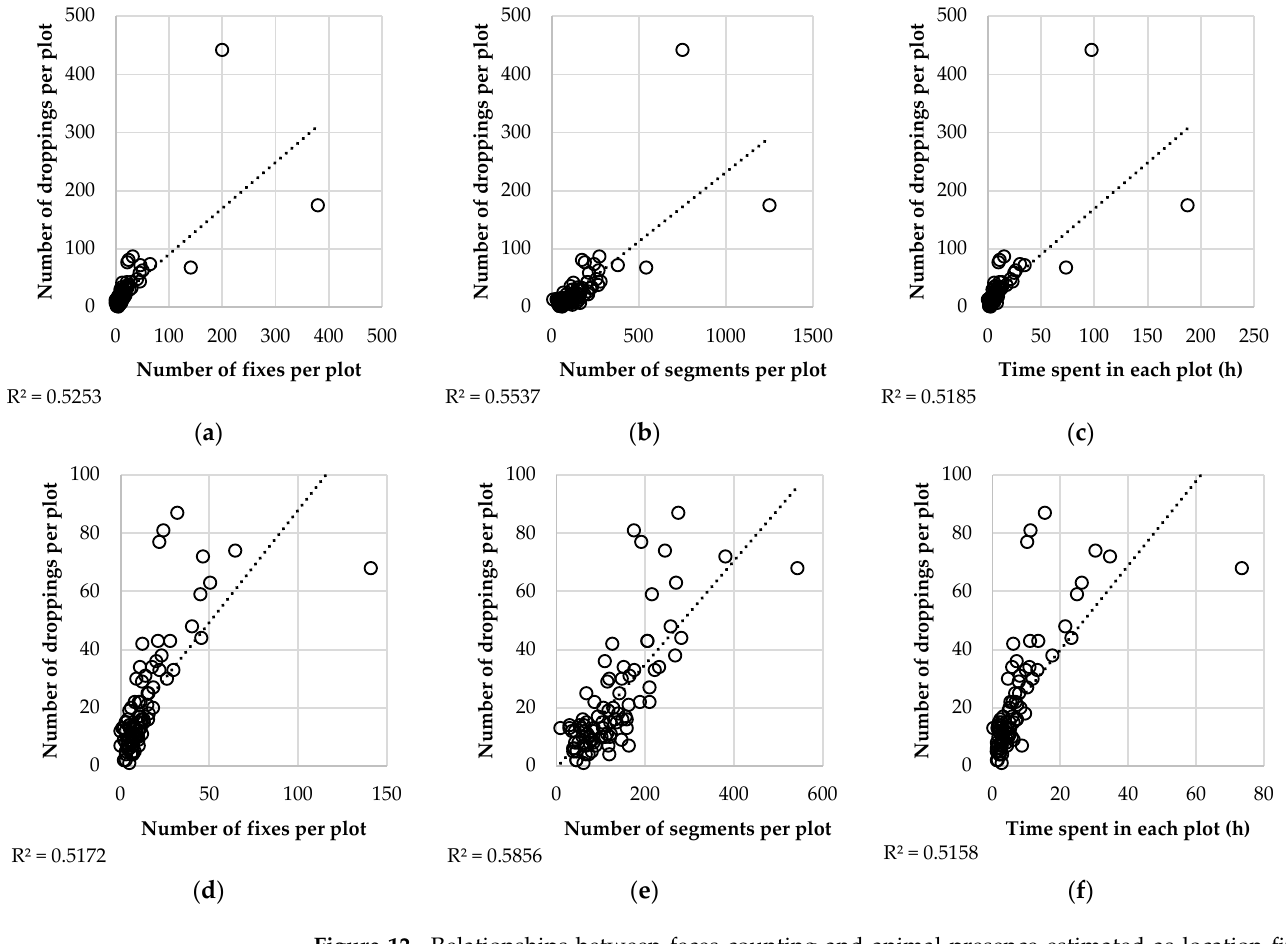
Figure 12. Relationships between feces counting and animal presence estimated as location fix counting ( a , d ), trajectory segment counting ( b , e ) or time spent inside plot ( c , f ), including ( a – c ) and excluding ( d – f ) hotspots.